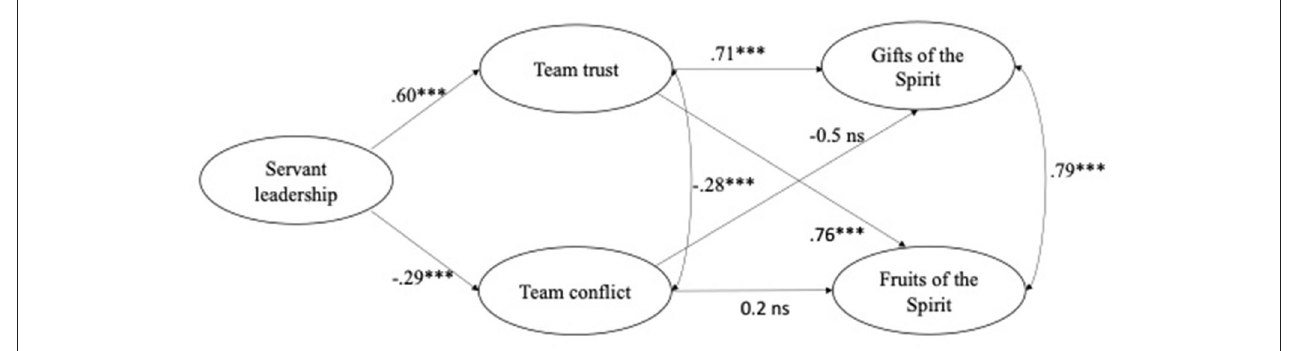
FIGURE 1 | The hypothesized mediation model with SEM parameter and path estimates. *** p <